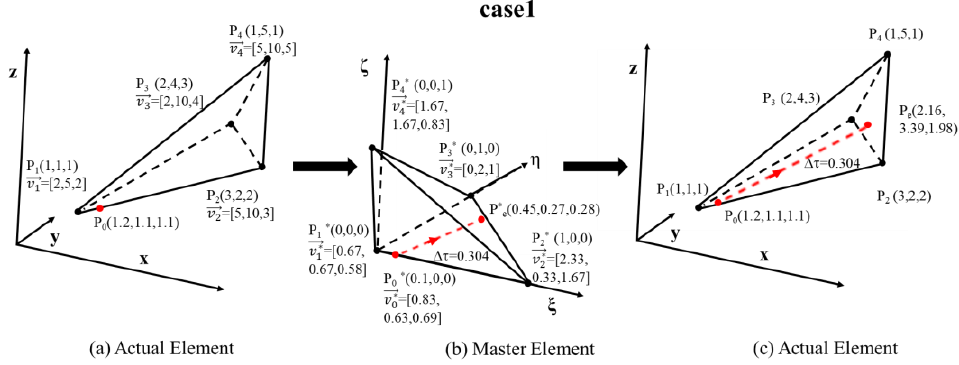
Figure 3. The procedure of tracing a streamline in a tetrahedron element generated by FEM. ( a ) The coordinates and velocity vectors at each vertex and the start point over a tetrahedron element in Actual Element. ( b ) The results of coordinates and velocity vectors transformed to Master Element and a streamline trajectory from the start point to the exit point in the Master Element, as well as the Time of Flight (TOF). ( c ) The streamline trajectory and coordinates of each vertex, start point, and exit point, which mapped back to Actual